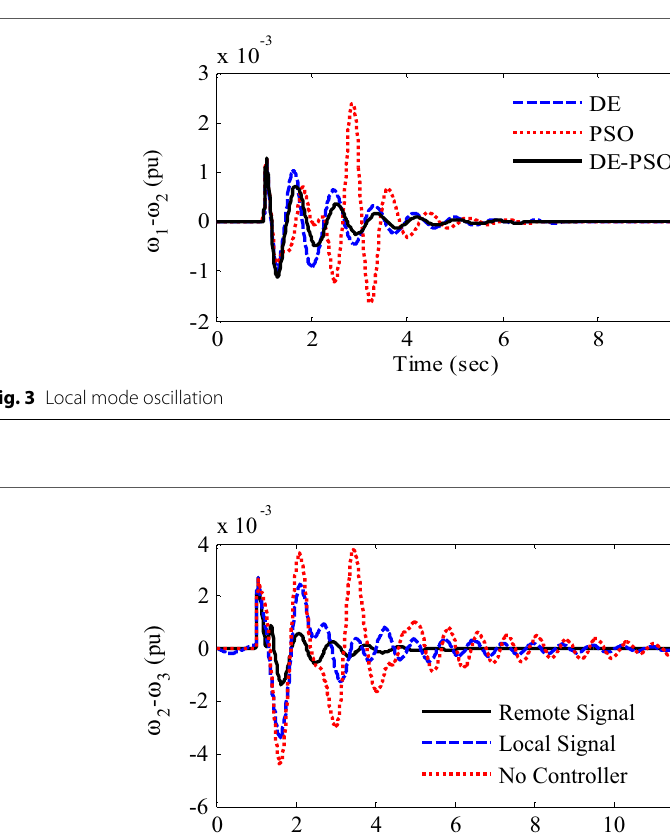
Fig. 4 Inter-area mode oscillation